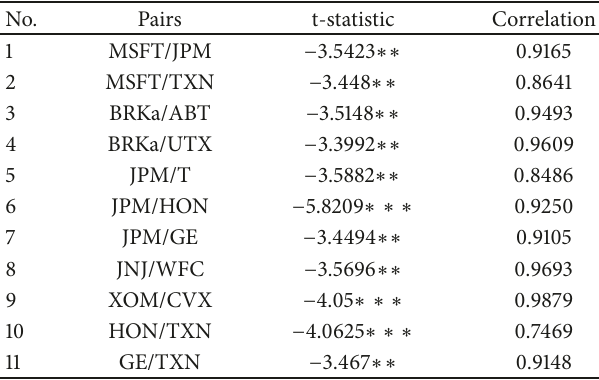
Table 2: Summary statistics for pairs verified using cointegration